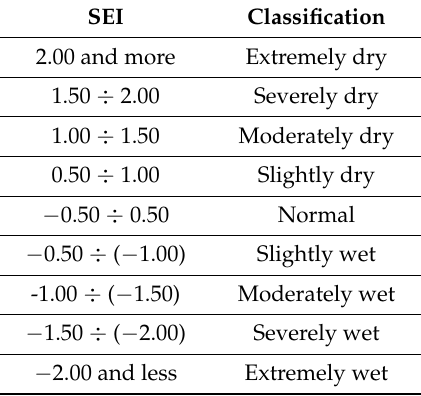
Table 4. Classification of Standardised Evaporation Index (SEI) for months and